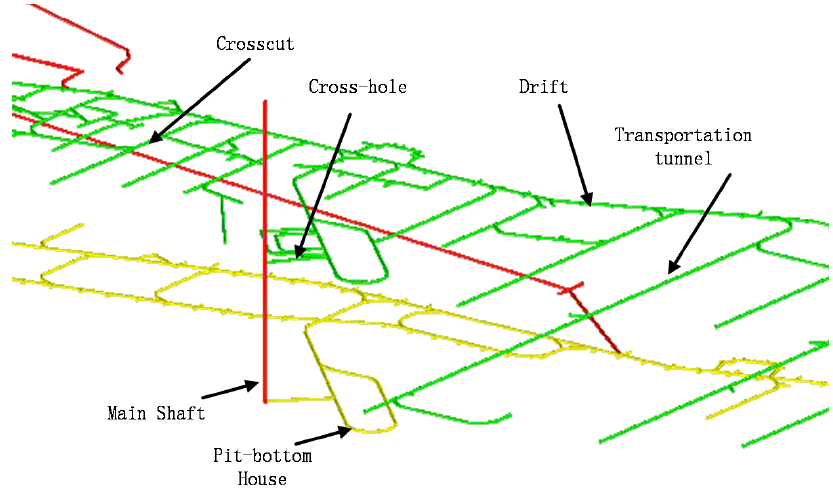
Figure 2. Mine layout.